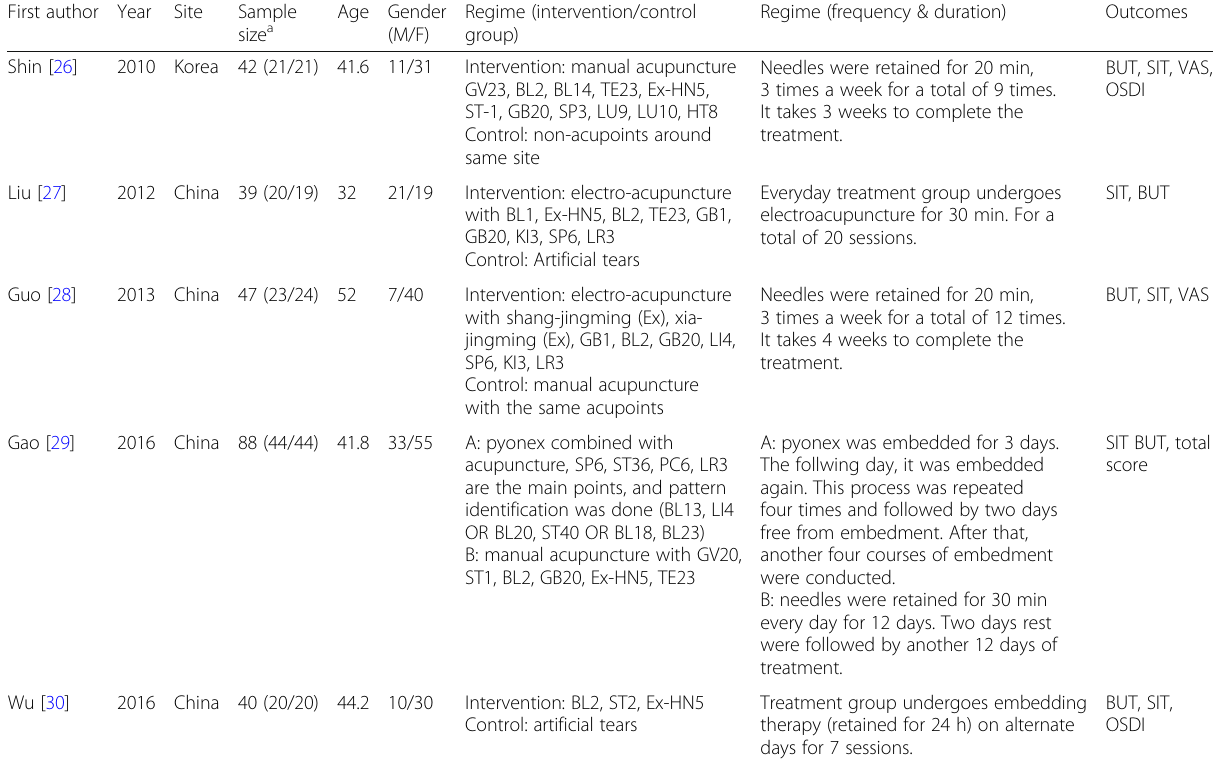
Table 2 Characteristics of included studies (other kinds of interventions)